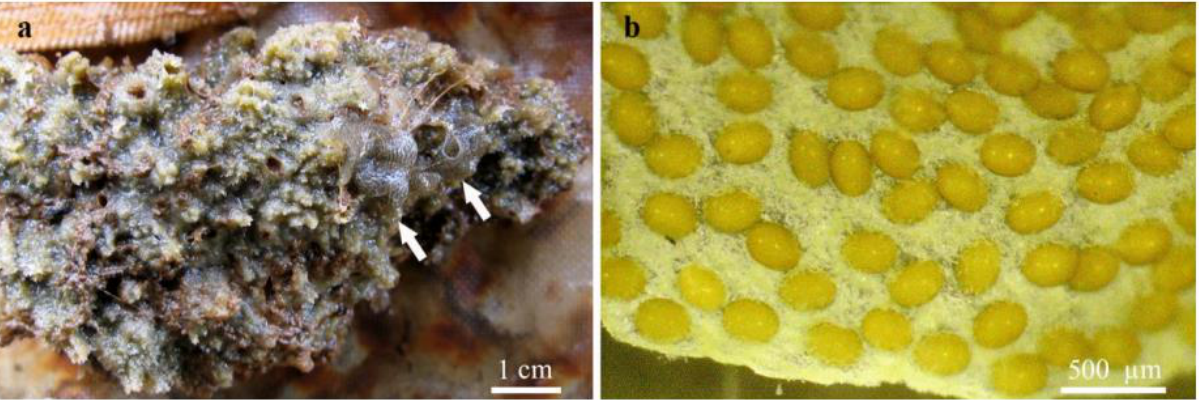
Figure 6. Eggs of Povilla heardi (Ephemeroptera, Polymitarcyidae) on Corvospongilla siamensis (Lower Mekong, Southeast Asia). ( a ) Egg jelly envelopes (arrows) on the irregular surface of a live sponge. ( b ) Eggs viewed by light microscopy.